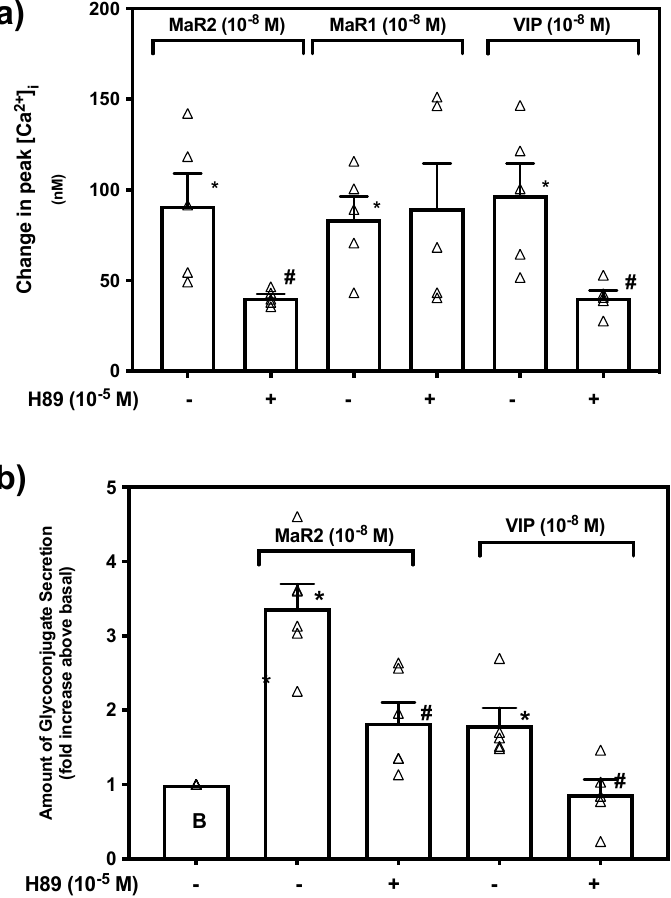
Figure 9. Maresin 2 uses protein kinase A to increase [Ca 2+ ] i and stimulate secretion in rat conjunctival goblet cells. Goblet cells were incubated with the protein kinase A (PKA) inhibitor H89 (10 − 5 M) for 30 min and then stimulated with MaR2 (10 − 8 M) or the positive controls MaR1 (10 − 8 M) and VIP (10 − 8 M) to measure the change in peak [Ca 2+ ] i ( a ) , or secretion ( b ). Note that MaR1 was not used as an agonist in ( b ). Data are mean ± SEM of five ( a ) and six ( b ) experiments. White triangles indicate individual data points. * shows significance above basal. # shows significance between agonist and inhibitor followed by agonist.